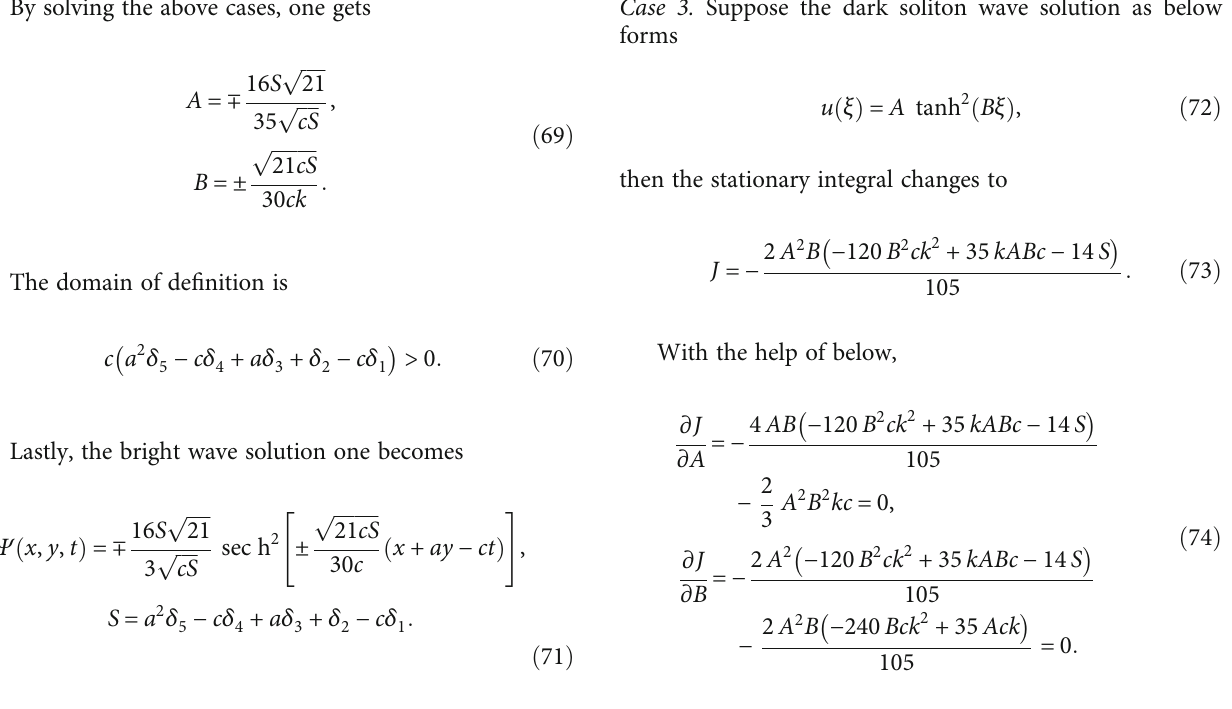
= : 5, a = 1 : 5, a = 2, a = 1, Ω = 1 : 9, Ω 1 2 3 4 1